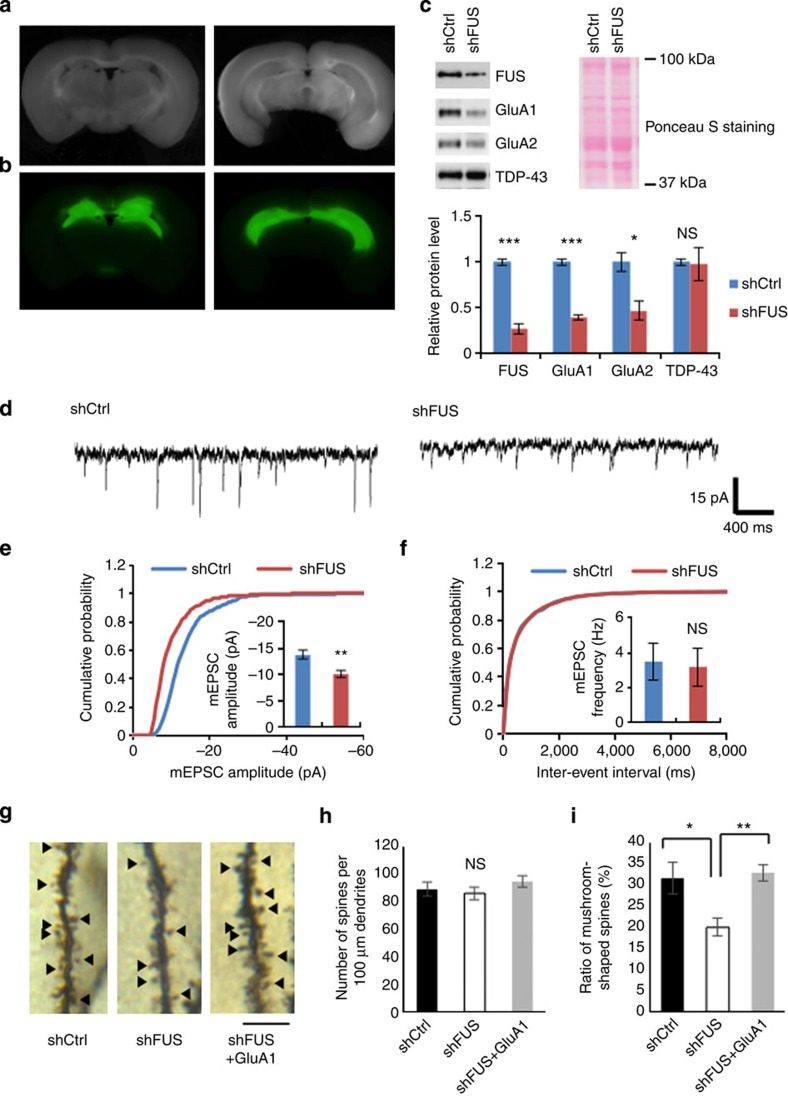
shRNA-mediated knockdown of FUS in mouse hippocampus affects synaptic transmission and spine morphogenesis at CA1 apical dendrites.(a, b) Representative images of AAV-injected brain sections photographed by bright-field (a) and fluorescence (b) microscopy. Images at anterior (left) and posterior (right) sections are representatively shown. (c) The lysates were prepared from two transduced ‘green' hippocampal slices per animal and western blotted with the indicated antibodies. Protein levels were quantified in three control and three FUS knockdown mice (FUS: t=10.40, ***P=0.0005; GluA1: t=13.24, ***P=0.0002; GluA2: t=3.593, *P=0.023; TDP-43: t=0.1447, P=0.89; unpaired t-test). Ponceau S staining indicates equal loading. (d) Representative mEPSC sample traces from the control (n=7) and FUS knockdown (n=7) hippocampal slices. (e, f) Cumulative distributions of mEPSC amplitude (e) and frequency (f) from the control and FUS knockdown hippocampal slices. The insets show mean±s.e.m. for mEPSC amplitude (t=3.400, **P=0.0053, unpaired t-test; e) and frequency (t=0.1946, P=0.85, unpaired t-test; f). (g) Representative images of a dendritic segment of CA1 pyramidal neurons of the hippocampus from mice injected with AAV-shCtrl (n=9 dendrites from three mice), AAV-shFUS (n=9 dendrites from three mice) and AAV-shFUS plus AAV-GluA1 (n=6 dendrites from three mice). Mushroom spines are indicated with arrowheads. Scale bar, 5 μm. (h) Spine number was quantified along a 100-μm segment from the origin of primary apical dendritic branches of Golgi-impregnated CA1 pyramidal neurons. No statistical difference was detected (P>0.05, one-way analysis of variance (ANOVA)). (i) Mushroom-shaped spines over the total spines as in h were counted (F(2, 21)=5.843, **P=0.0096, one-way ANOVA; *P<0.05, Tukey's test post hoc). NS, not significant.